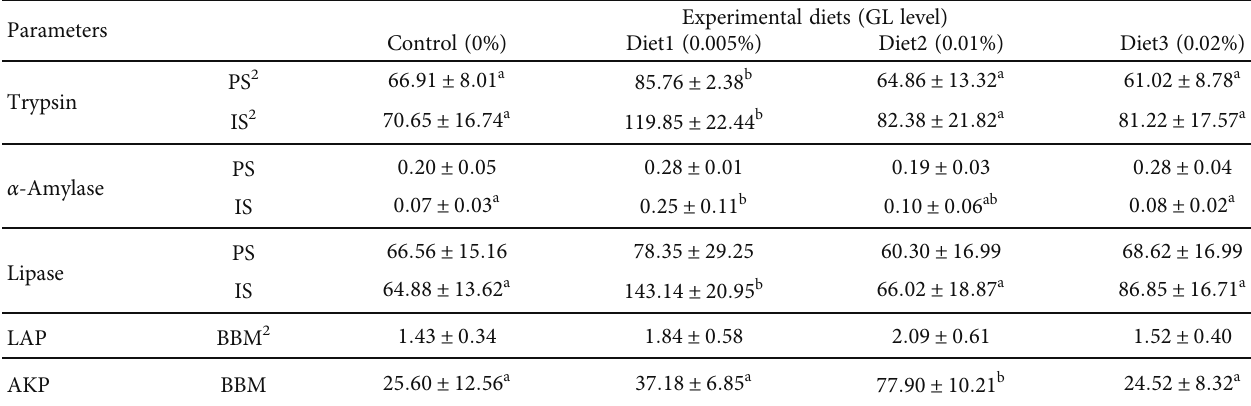
Data were expressed as means ± S : E : M , n = 3 . Means in the same column sharing a same or no superscript letter are not signi fi cantly di ff erent determined by Tukey ’ s test ( P > 0 : 05 ). 2 PS: Pancreatic segments; IS: Intestinal segments; BBM: Brush border